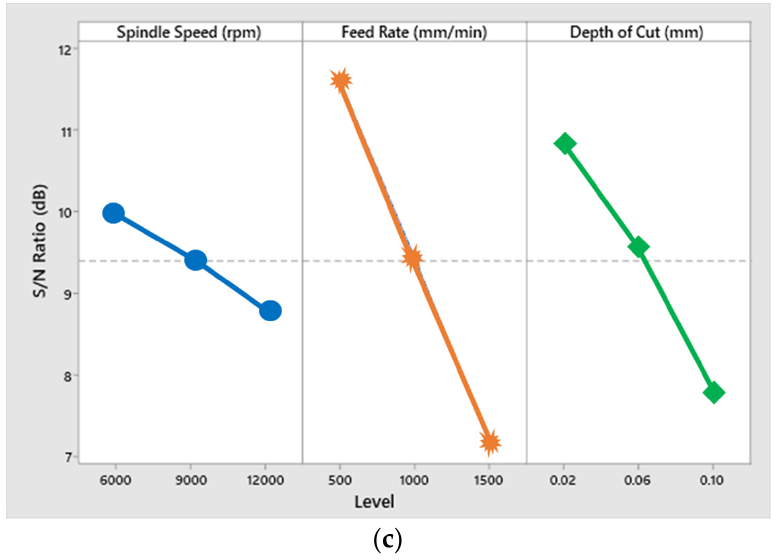
Figure 3. Surface roughness factor response plot for ( a ) unassisted, ( b ) laser-assisted, and ( c ) hybrid- assisted systems.